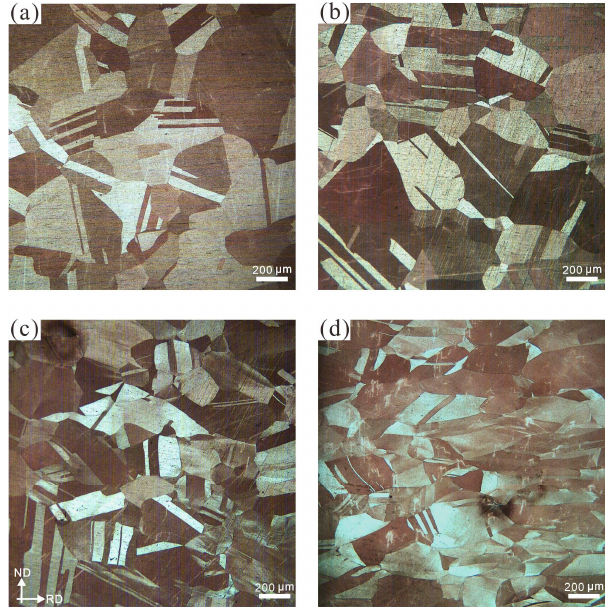
Figure 2. Metallographic images of copper with different degrees of deformation (ND stand for the normal direction, RD stand for the rolling direction): ( a ) undeformed, ( b ) 10%, ( c ) 20% and ( d )